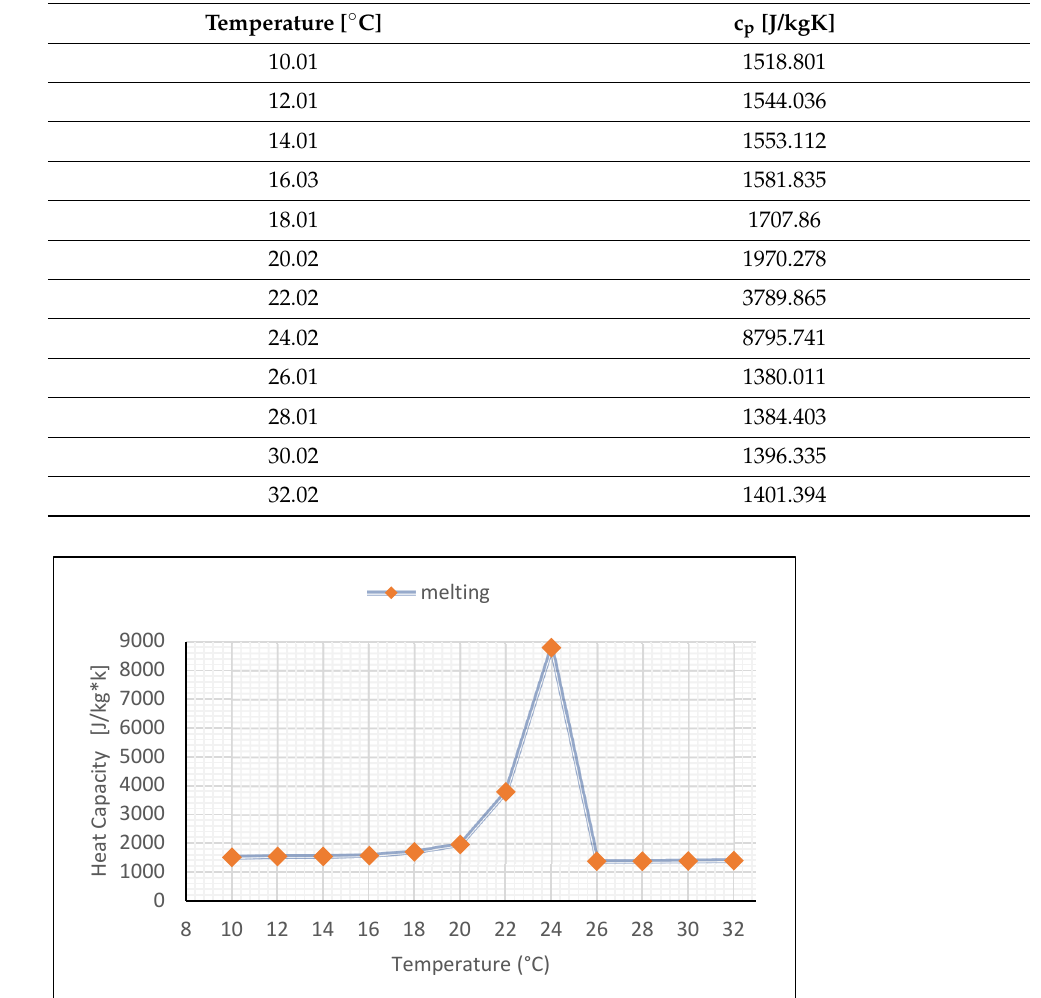
Table 1. Thermal conductivity coefficients of Micronal ® PCM SmartBoard™ 23 plasterboard in two Table 2. Mass thermal capacity of Micronal ® PCM SmartBoard™ 23, melting stage: 10–32 ◦ C. temperature ranges: from 0 to 20 °C and from 10 to 30 °C. Melting